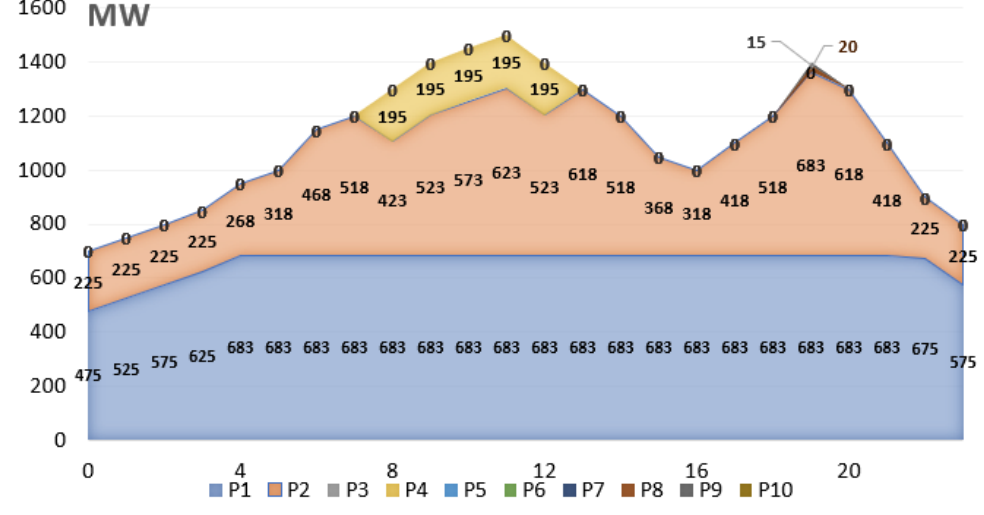
14 Table 5. Global optimum UC of the proposed BM solution (* indicates the priority ordered units, while bold numbers show the must-run units). Rank( i* ) 0 Table 6. Comparative results pertaining the 10-unit system.